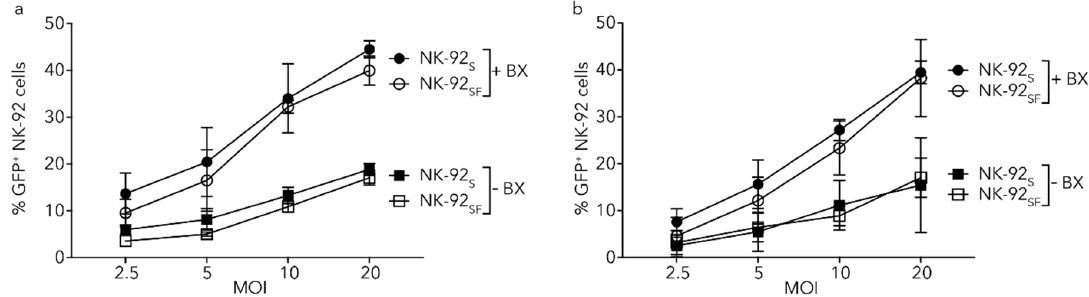
Figure 7. Serum-starvation of NK-92 cells does not change transduction efficiency with lentiviral vectors. CD56 + GFP + NK-92 cells three days after transduction with non-purified ( a ) or purified ( b ) LeGO-G2 virus in the absence or presence of BX-795. The graph represents the mean (+SEM) of two independent assays performed in duplicates. The LeGO-G2 virus is only introduced to express GFP, and the result was analyzed as GFP + percentage three days post-transduction.